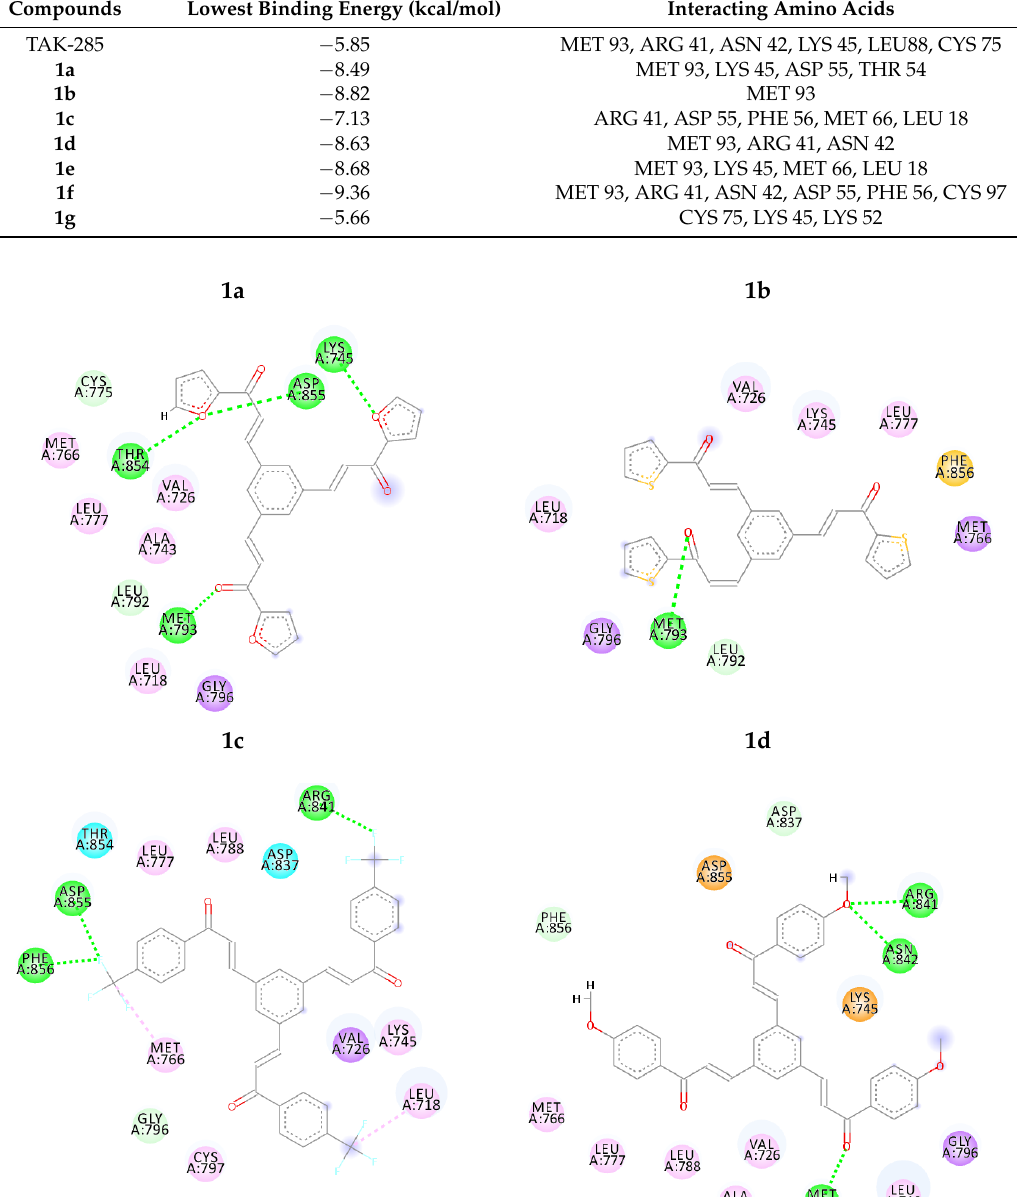
Table 1. The lowest binding energies obtained from AutoDock 4.2 and interacting amino acids.